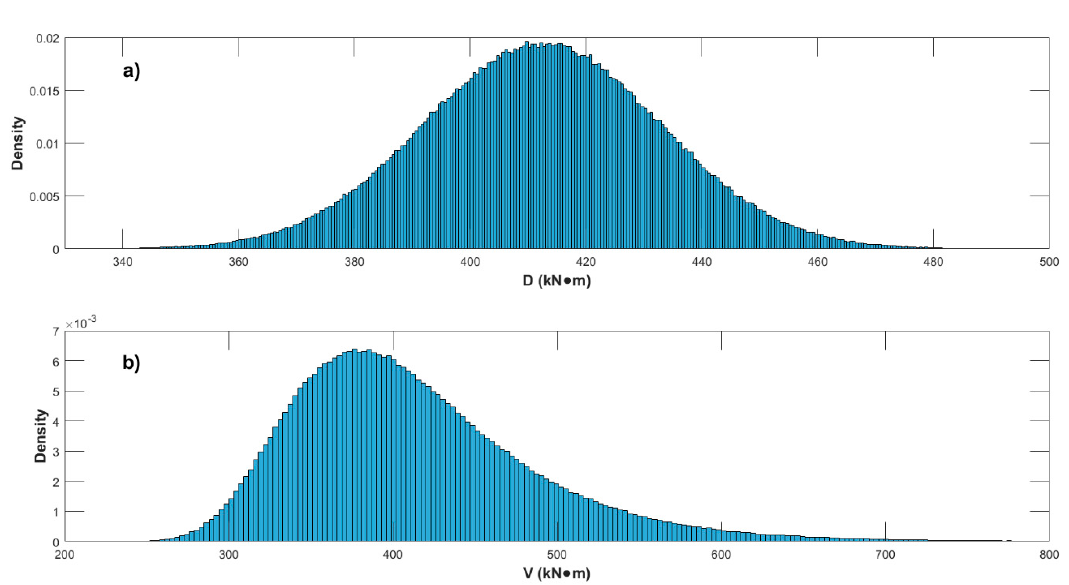
Figure A1. Histograms for 1 × 10 6 Monte Carlo simulations (MCS) of bending moment due to ( a ) dead load ( D ) and ( b ) live load ( V ).